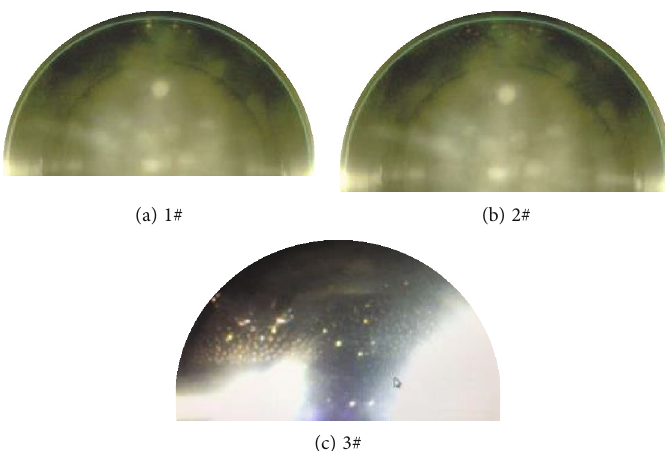
Figure 4: High temperature visualization of phase states of di ff erent solvent oil-water vapor systems.